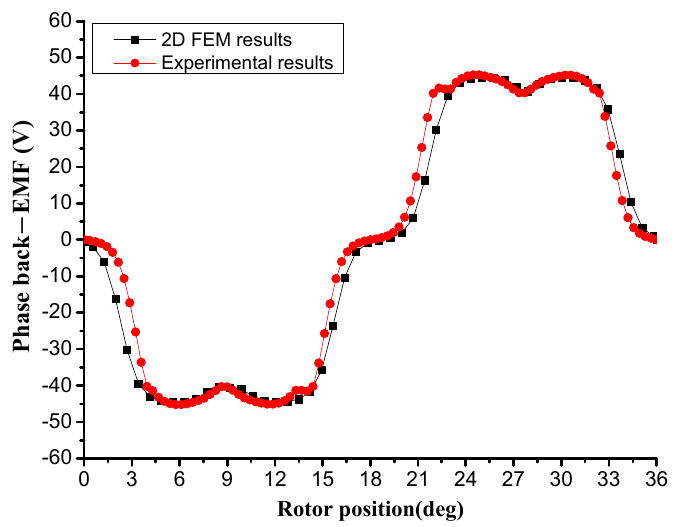
Figure 6. Comparison of the phase back electromotive force (back—EMF).